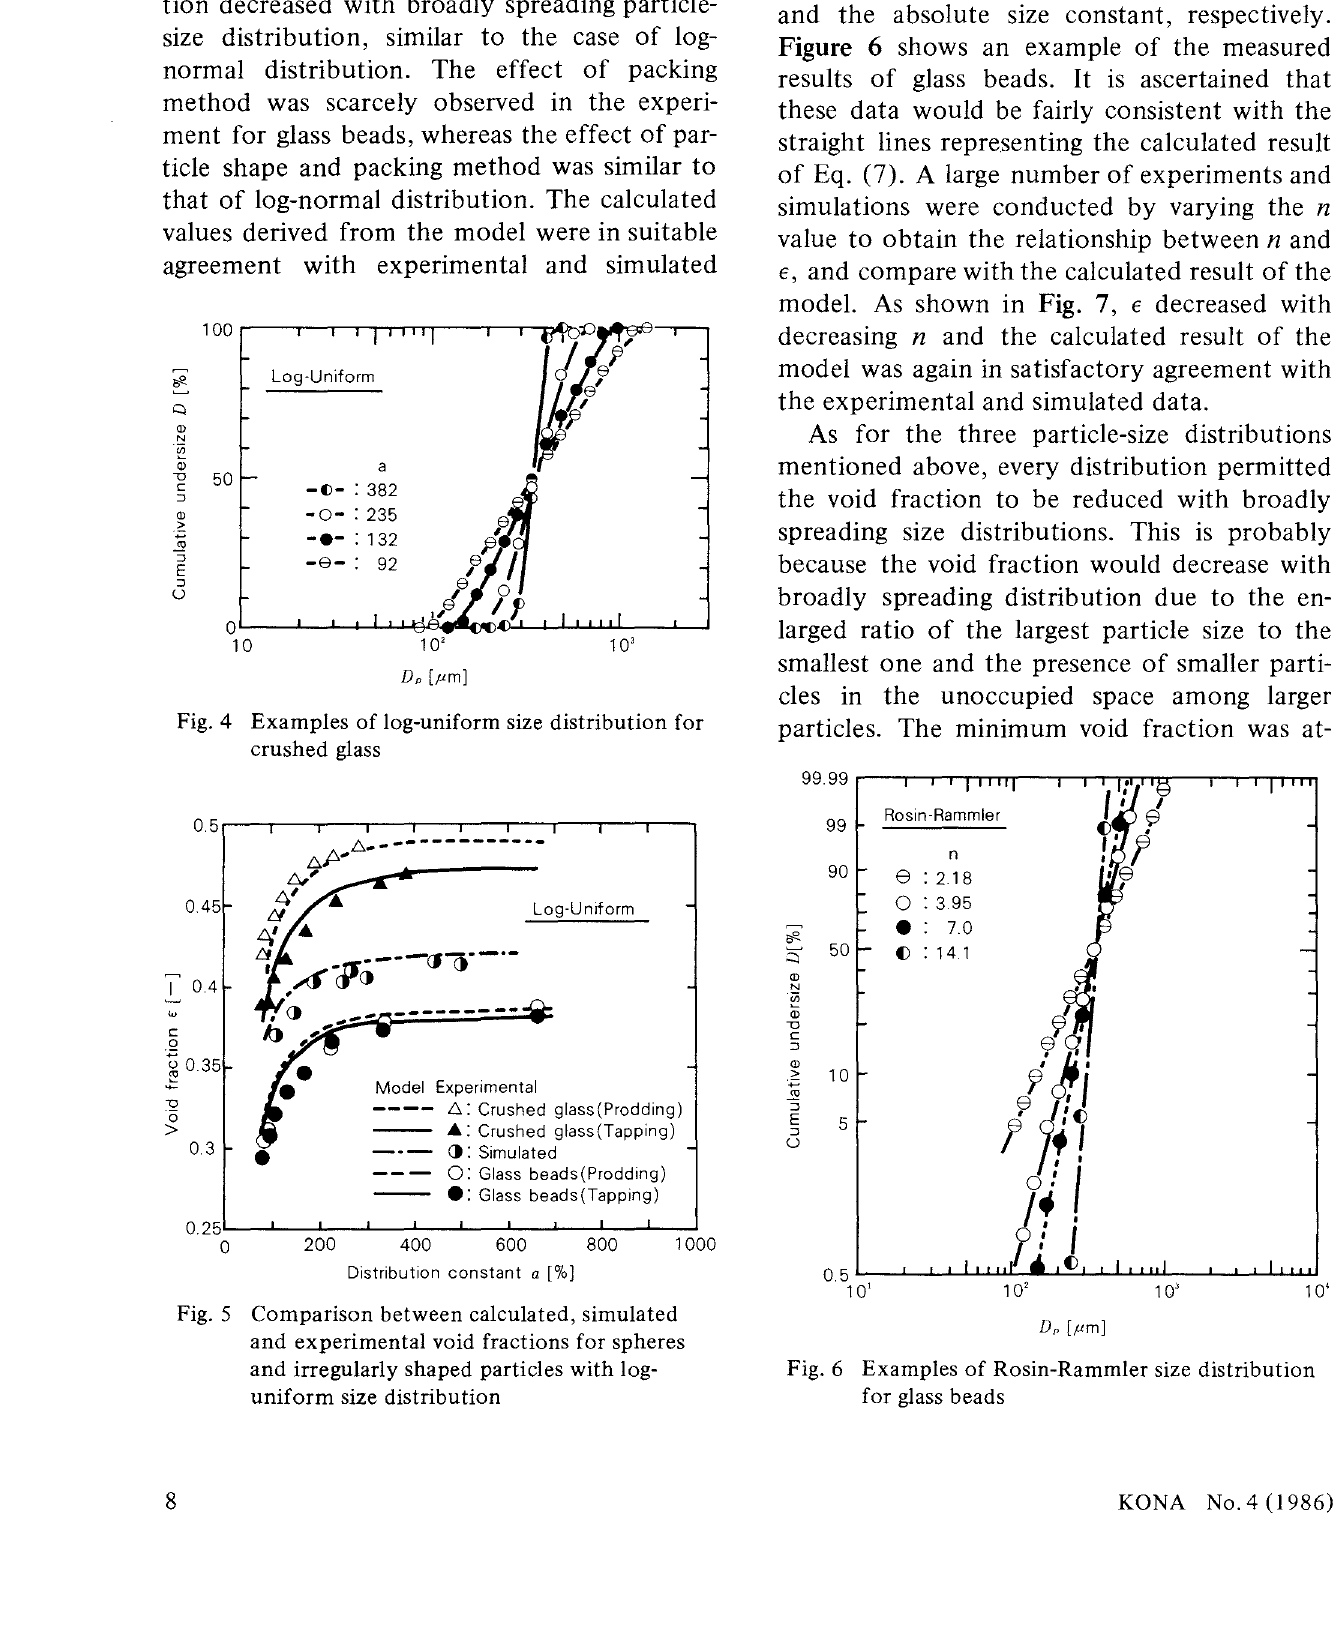
Fig. 5 Comparison between calculated, simulated and experimental void fractions for spheres and irregularly shaped particles with log uniform size distribution